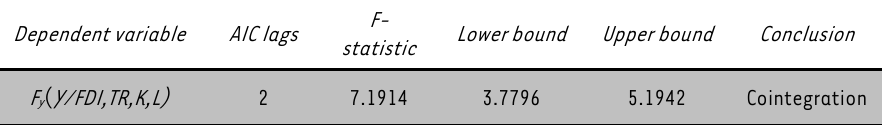
TABLE 2: Cointegration